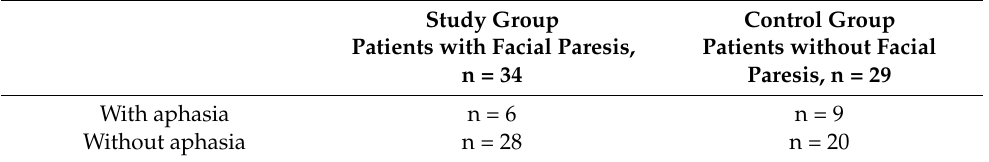
Table A6. Summary of facial paresis and aphasia information.